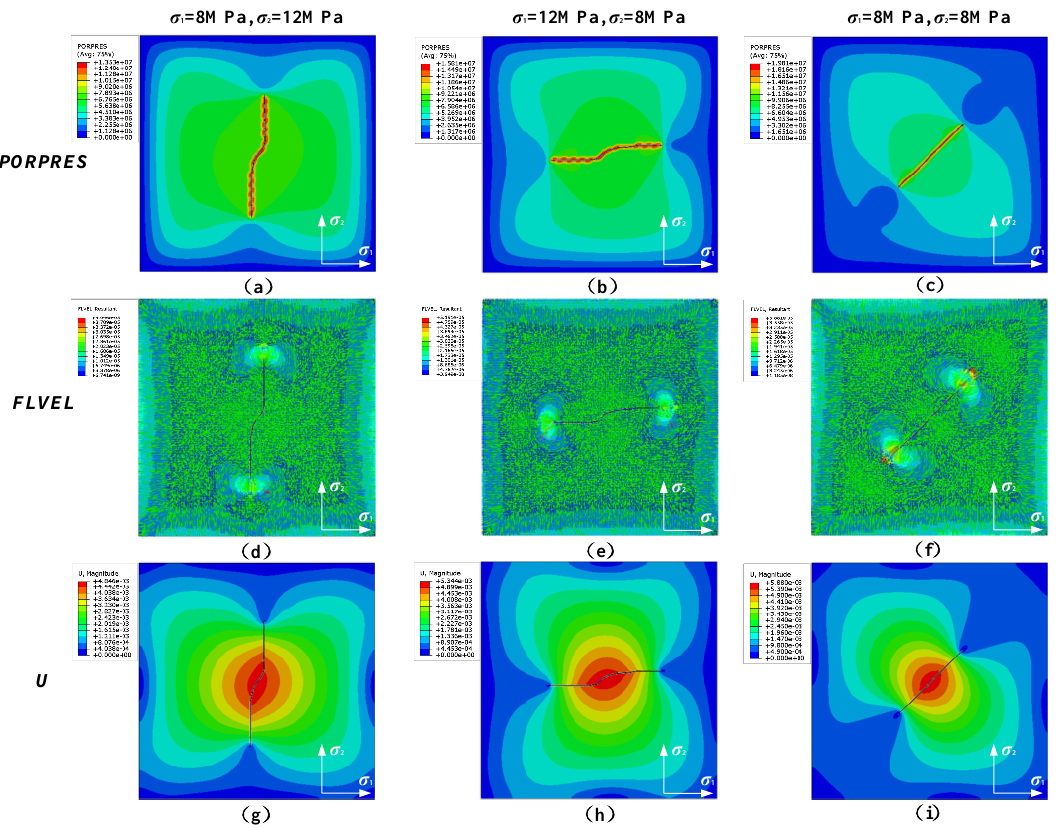
Figure 16. Fracture propagation effect of hydraulic fracturing in different stress fields. ( a ) PORPRES, σ 1 = 8 MPa, σ 2 = 12 MPa; ( b ) PORPRES, σ 1 = 12 MPa, σ 2 = 8 MPa; ( c ) PORPRES, σ 1 = 8 MPa, σ 2 = 8 MPa;